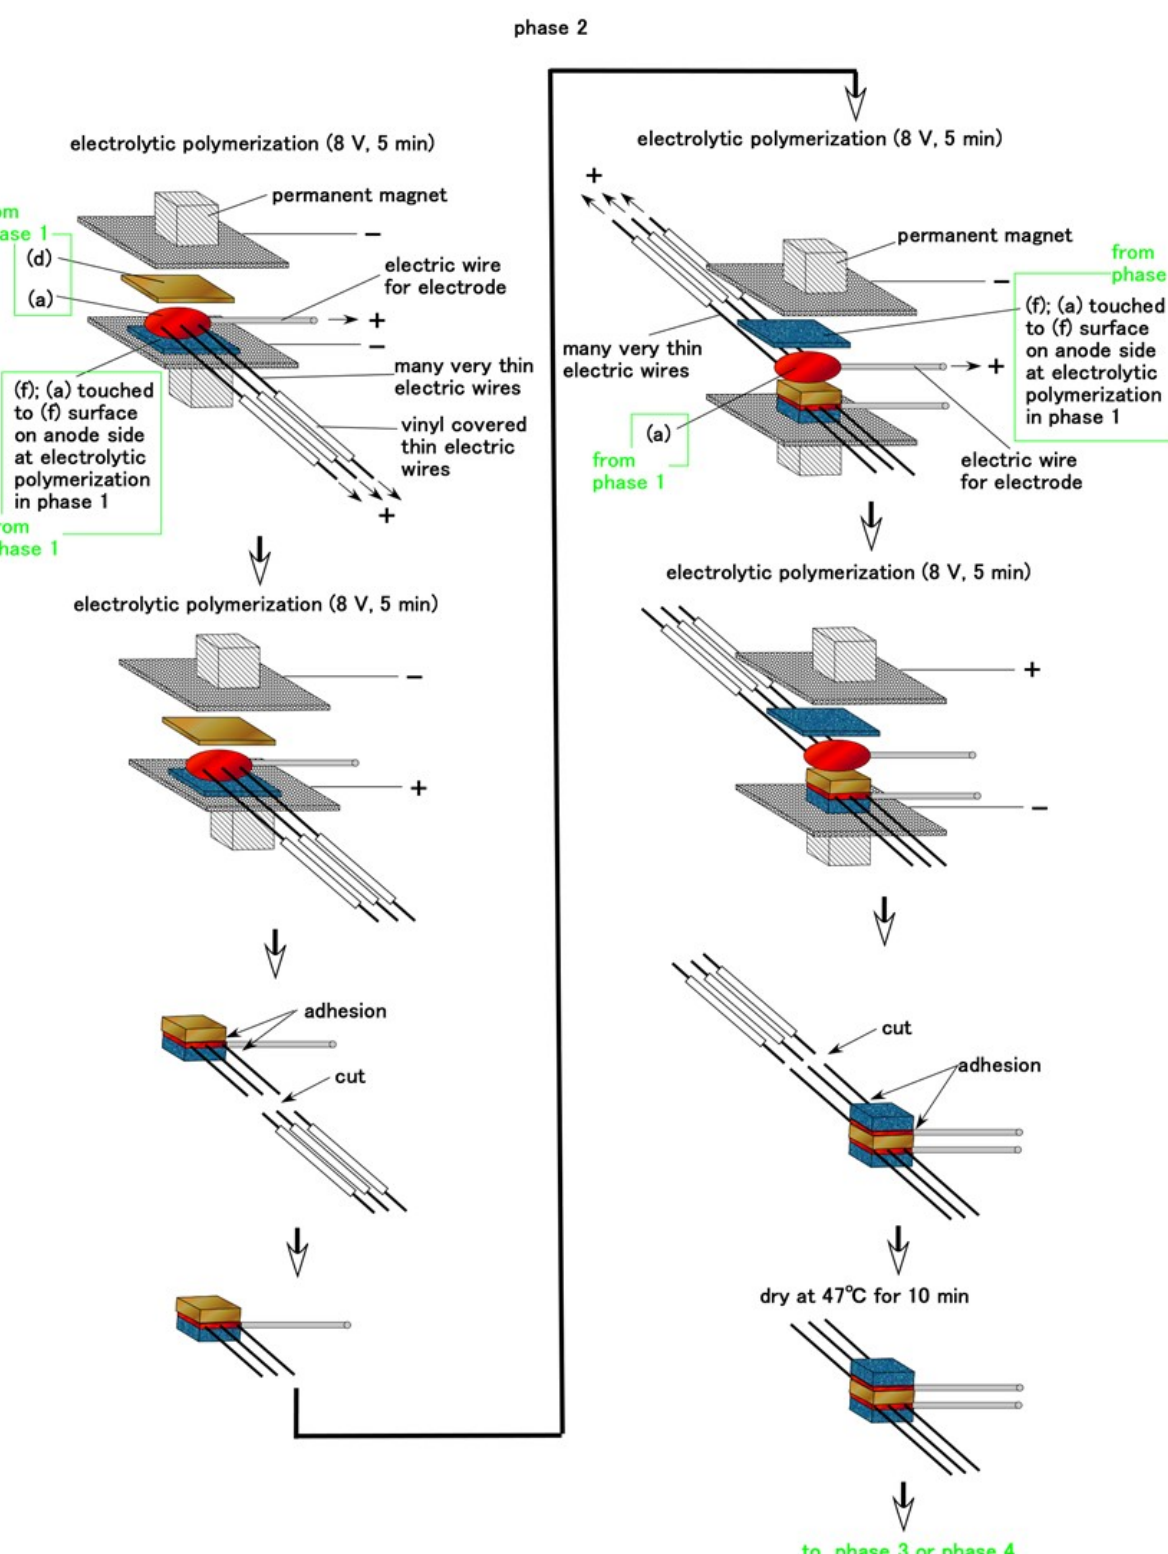
Figure 4. Schematic of the fabrication of cutaneous receptors of free nerve endings, Krause endbulbs and Meissner corpuscles during Phase 2.